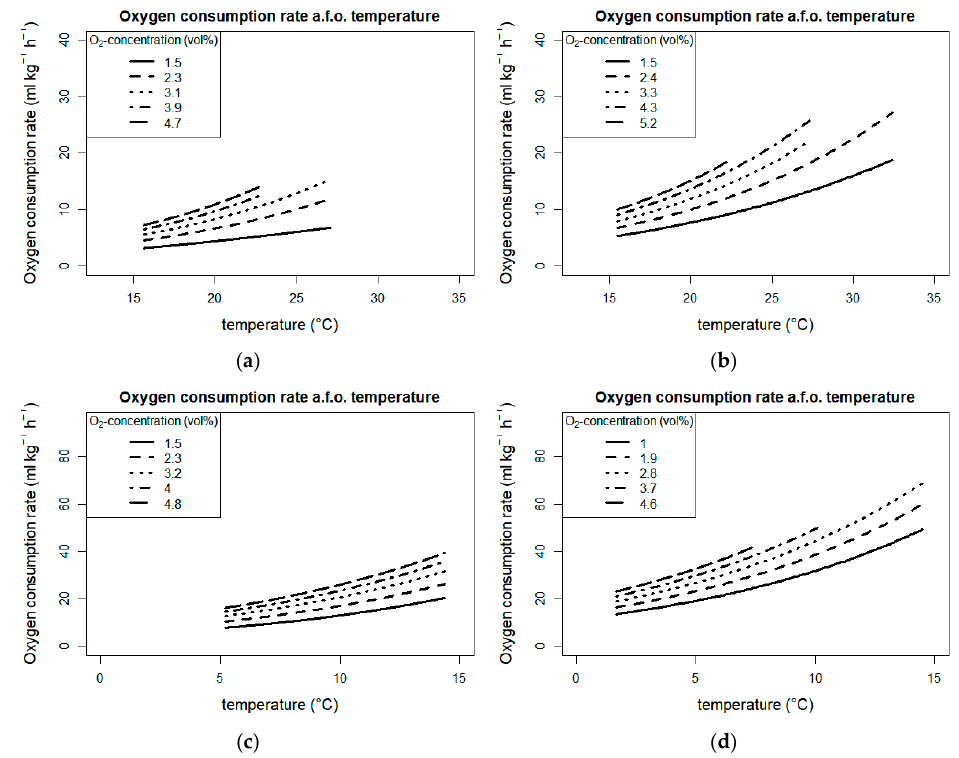
Figure 4. Oxygen consumption rate as a function of five different O 2 concentrations for ( a ) Phalaenopsis in February, ( b ) Phalaenopsis in March, ( c ) Chrysanthemum cv. B; ( d ) Chrysanthemum cv. C.